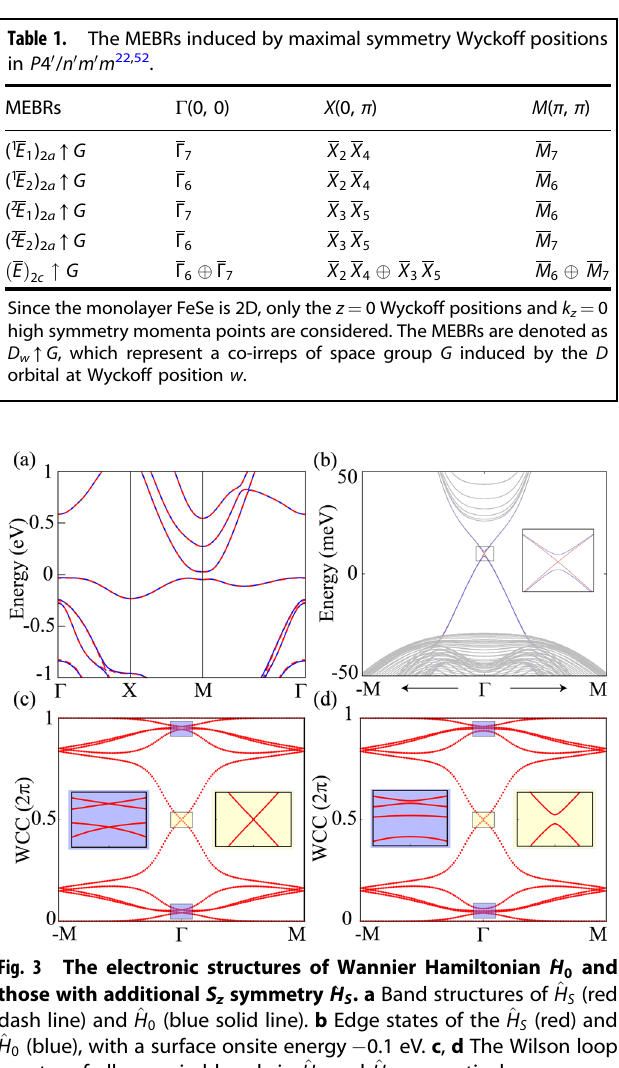
FeSe by an additional S z symmetry, i.e. ^ H S ¼ ð H 0 þ S z ^ H 0 S (cid:3) 1 and plot the band structures of ^ H S (red dash line) as a comparison to the bands of ^ H 0 (blue solid line) in Fig. 3a. The red bands in Fig. 3a match the blue bands very well, which strongly implies that the ^ H 0 is approximate to having S z symmetry. The approximately S z symmetry is also consistent with our fi rst-principles calculations, which display the weak hybridization between majority spin states and minority spin states as shown in Fig. 2a, b. Second, one can quantitatively estimate the S z -breaking process as a competition between the SOC interaction λ soc and the onsite magnetic polarization splitting Δ , where λ soc regards the spin mixing ability and Δ preserves spin conserving 30 . Reminding that the magnetic